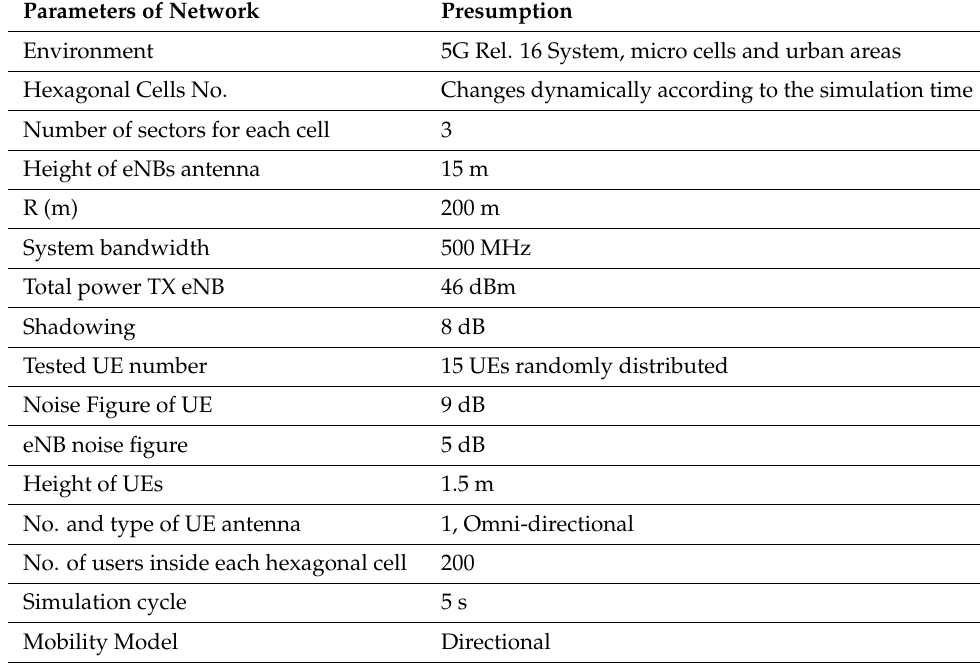
Table 2. The system simulation parameters